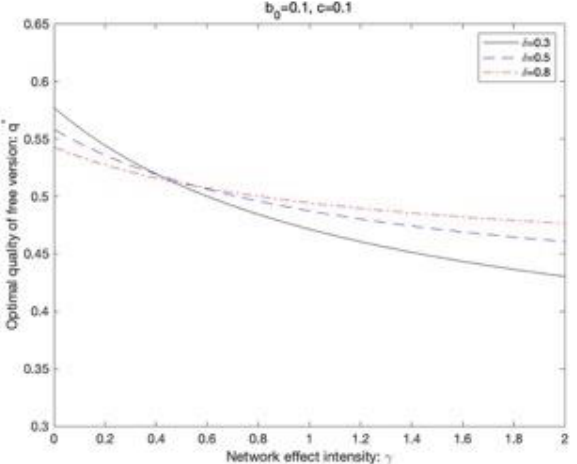
Figure 7. The impact of network effect intensity 𝛾 on free trial strategy design.